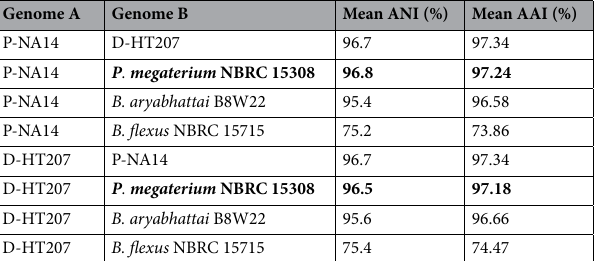
Table 1. ANI and AAI values (%) between two strains and type strains of phylogenetically related species. The highest ANI and AAI values between two strains and type strains of phylogenetically related species are in bold text.